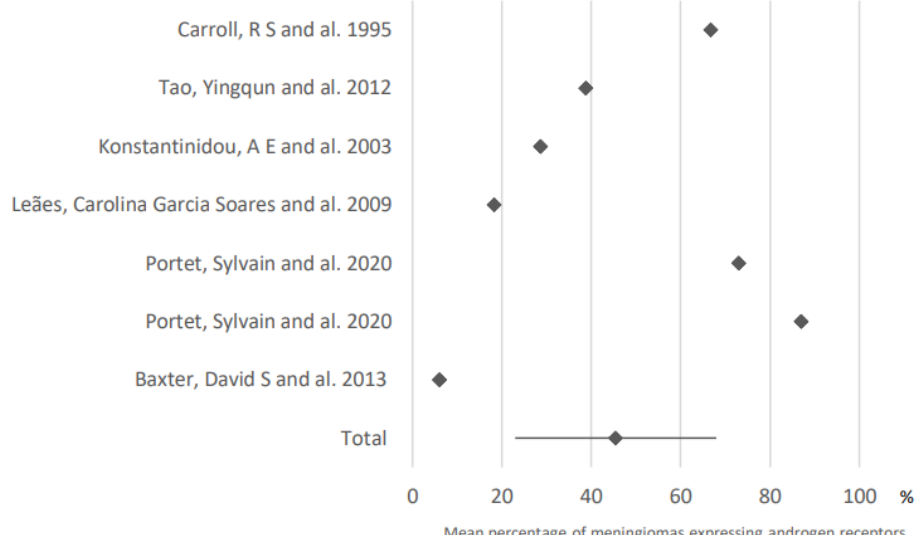
Figure 3. Expression of androgen receptors in meningiomas. The results are expressed as a mean associated with their 95% confidence interval. Number of articles analyzed related to the topic: 7. Number of included cases (total for all studies; minimum; maximum in each study): 613 (30;